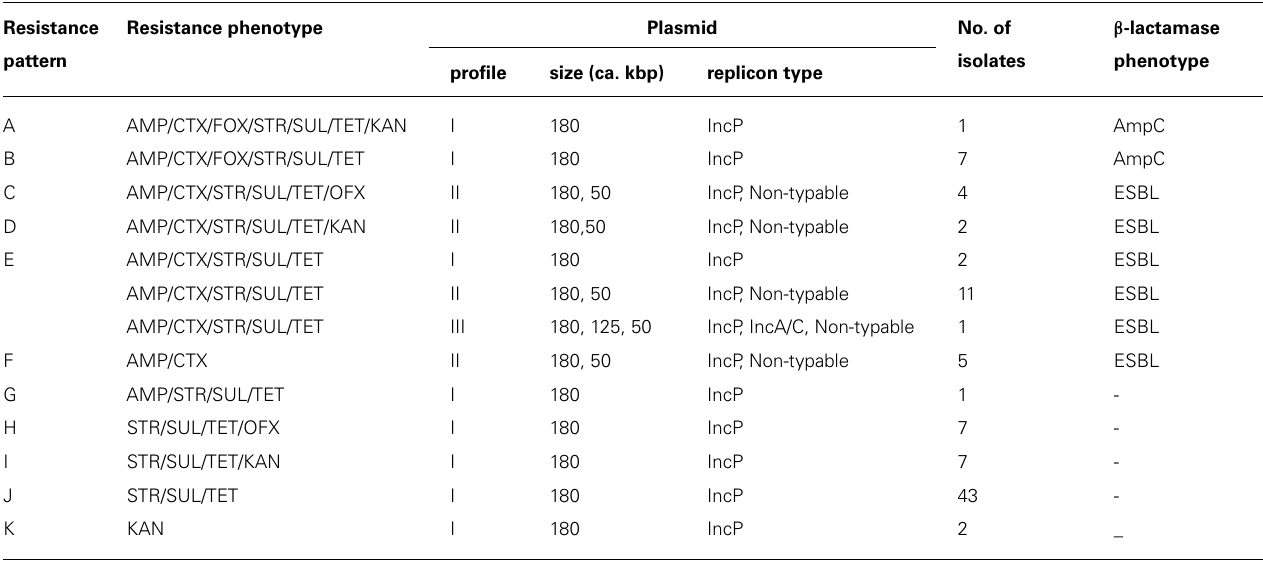
Table 2 | Distribution of resistance phenotypes, plasmid profiles and β -lactamase phenotypes in Salmonella Infantis isolates Resistance Resistance pattern